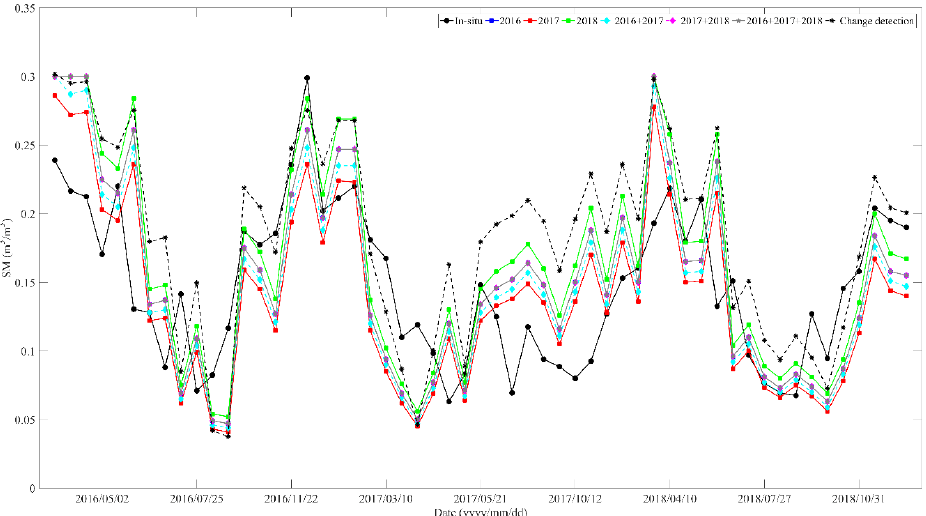
Figure 6. Time series of in situ and retrieved SM from AIEM with different effective roughness parameters computed from 2016, 2017, 2018, 2016+2017, 2017+2018, and 2016+2017+2018 and the SM retrieval results from the change detection method.